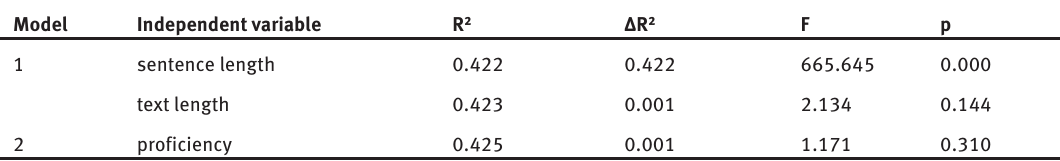
Table 5: Hierarchical multiple regression analyses of the effects of proficiency on DD in speech